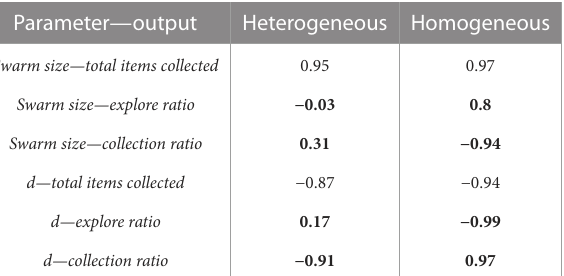
TABLE2 LHAcorrelationvaluesfortheNPS.Valuesinboldrepresenta bigdifference,greaterthan0.5,betweenheterogeneousand